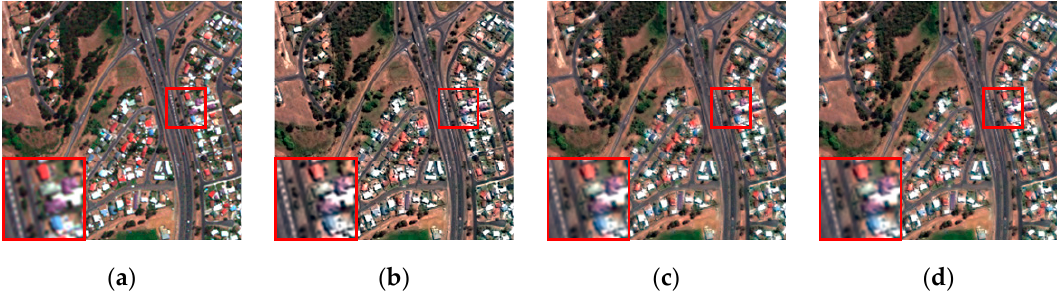
Figure 1. Fusion results of multispectral (MS) and panchromatic (PAN) images from the GeoEye-1 data set: ( a ) reference image; ( b ) fusion image of spectral modulation (SM) based method; ( c ) fusion image of method without local adaptive spectral modulation (LASM); ( d ) fusion image of method using LASM.